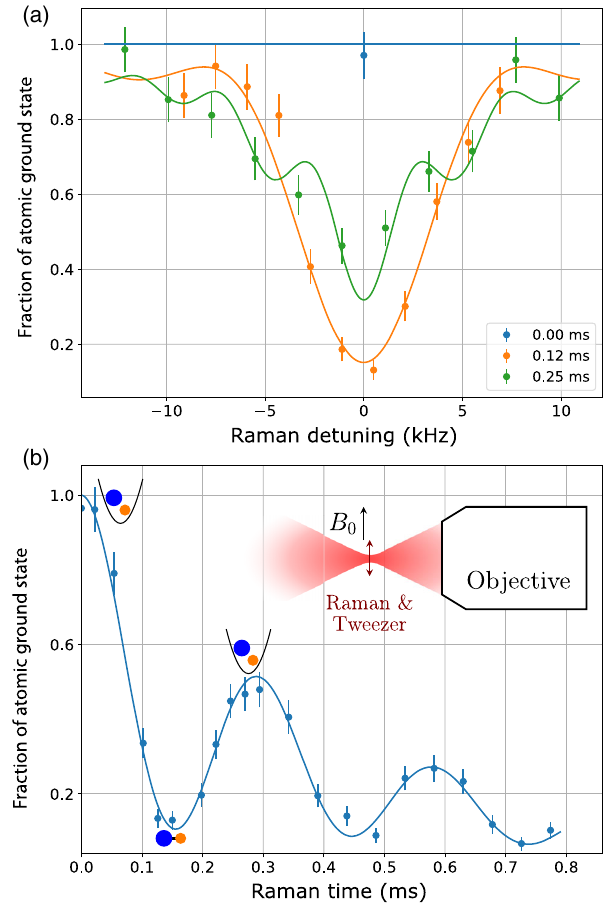
FIG. 3. Coherent transfer of atoms to molecules. The molecular state is dark to the imaging step and corresponds to zero signal. (a) Raman difference frequency scans for various durations showing the resonance as a function of the detuning from the fitted resonance at 770.5715(1) MHz, near the calculated value of 763 MHz. (b) Raman pulse-length scan on resonance. A decaying Rabi oscillation shows the coherence of the Raman transfer process. A model is fitted to (a) and (b) to determine the Raman Rabi frequency and loss rates. Inset: geometry and polarization of trap and Raman beam relative to the magnetic field. The 3.25 mW beam is focused to a waist of 0 . 9 μ m that confines the atoms and molecule. A perpendicular B 0 ¼ 8 . 83 ð 2 Þ G magnetic field de- fines the quantization axis and the atoms experience predomi- nantly π -polarized